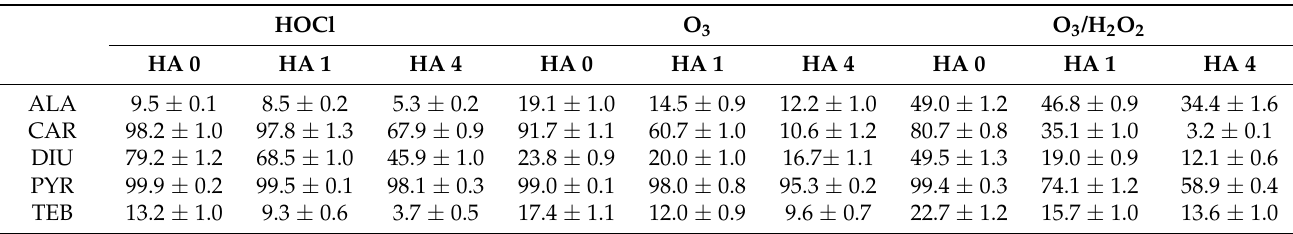
Table 4. The effects of HA on the removal efficiencies (%) of the selected pesticides by HOCl, O 3 and O 3 /H 2 O 2 processes (initial concentration of each pesticide = 2 µ M, the concentrations of HA = 0, 1, and 4 mg/L, reaction time = 0.5 h, temperature = 25 ◦